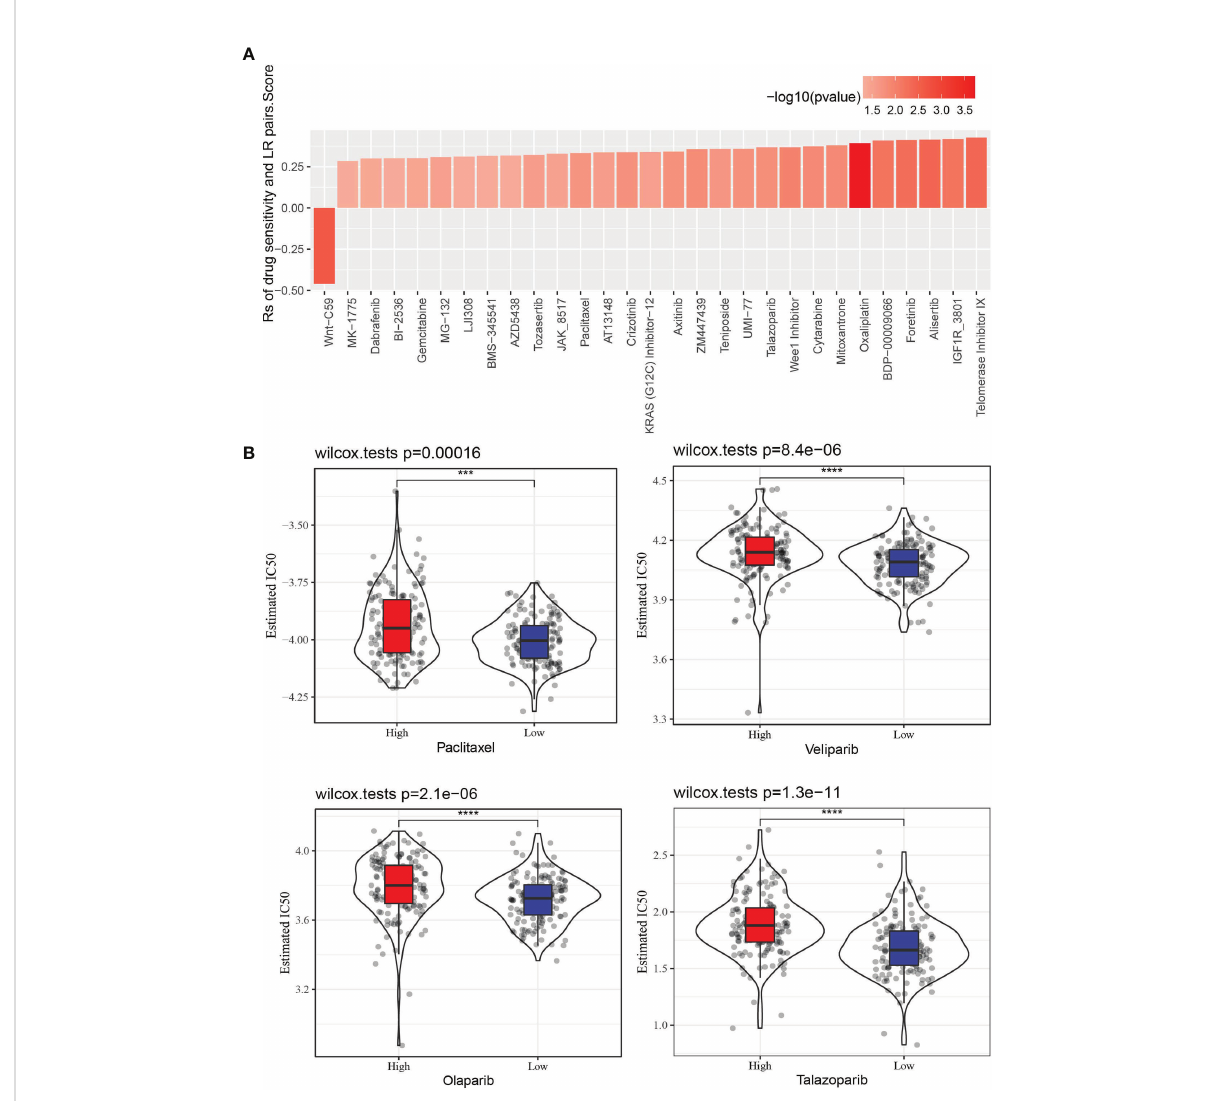
FIGURE 9 The relationship between LR pairs score and drug sensitivity. (A) The correlation between LR pairs score and AUC of drug-sensitive curve, Spearman correlation analysis. (B) The violin plot dispalys the differences in the estimated IC50 values of Paclitaxel, Veliparib, Olaparib, Talazoparib between distinct LR pairs score groups, wilcoxon test. The asterisks represented the statistical p value, ***p < 0.001,